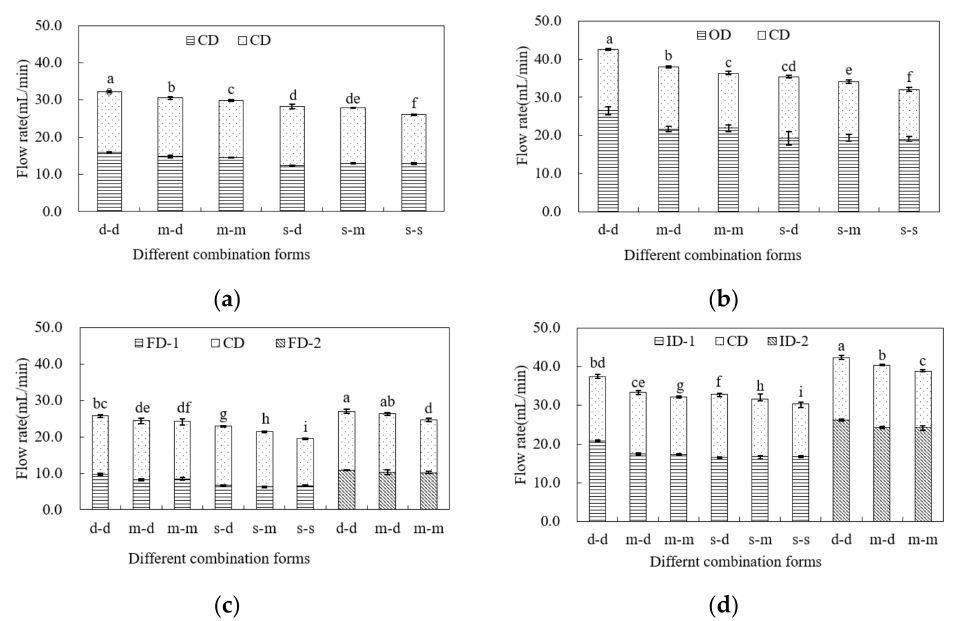
Figure 4. Flow rate of different combined drainage forms under a stable ponding water condition; ( a ) Conventional subsurface drainage; ( b ) Open-ditch and conventional subsurface drainage; ( c ) Filter and conventional subsurface drainage ( d ) Improved and conventional subsurface drainage. Note: Means followed by the same letter within a figure are not significantly different according to T-test ( p <